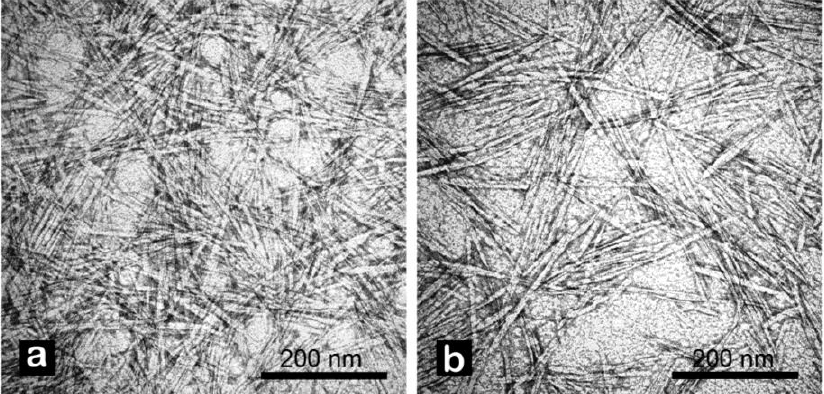
Figure 2. TEM analysis of CNC from tomato waste obtained by chemical ( a ), and enzymatic ( b ) extraction protocols. Images were recorded at 100 kX. Samples were stained with 2% uranyl acetate in distilled water prior to observation.